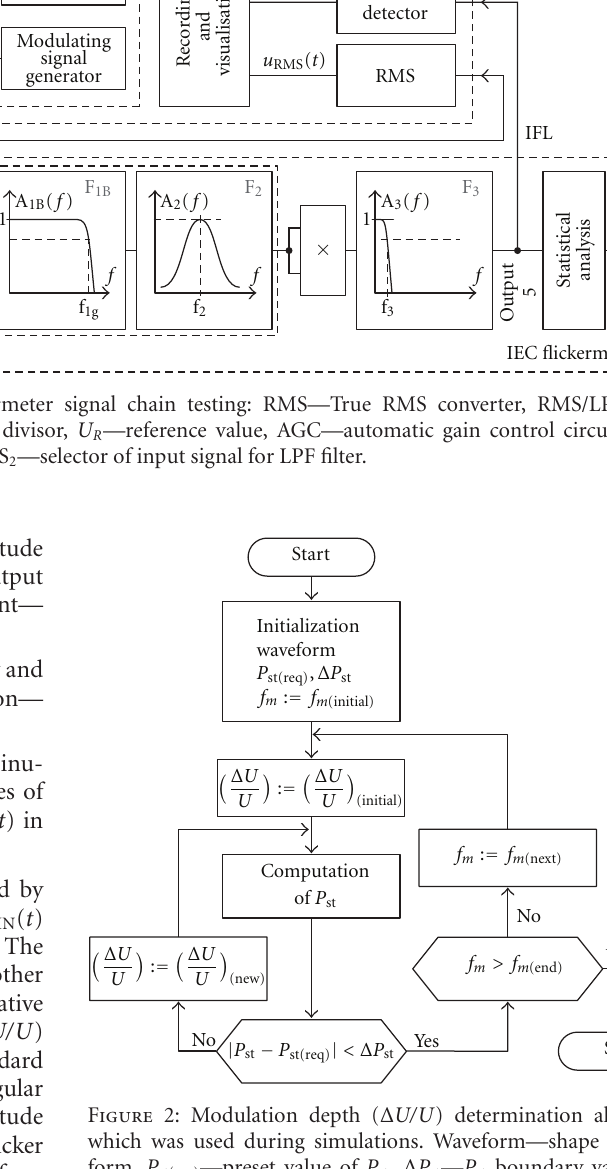
Figure 2: Modulation depth ( Δ U/U ) determination algorithm, which was used during simulations. Waveform—shape of wave- form, P st(req) —preset value of P st , Δ P st — P st boundary value (cal- culation of ( Δ U/U ), for a given f m frequency value; ends when P st value enters the P st(req) ± Δ P st